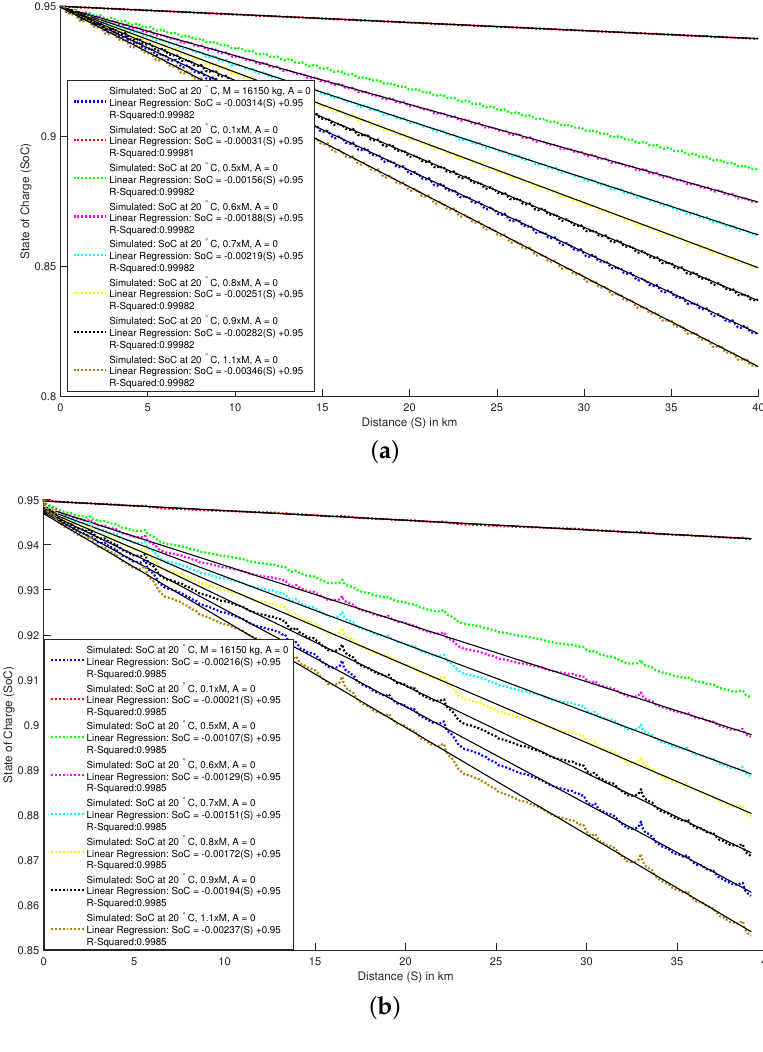
Figure 1. SoC versus distance for different gross masses of EV: ( a ) standardised on-road test cycle (SORT) 3 and ( b ) highway fuel economy driving schedule